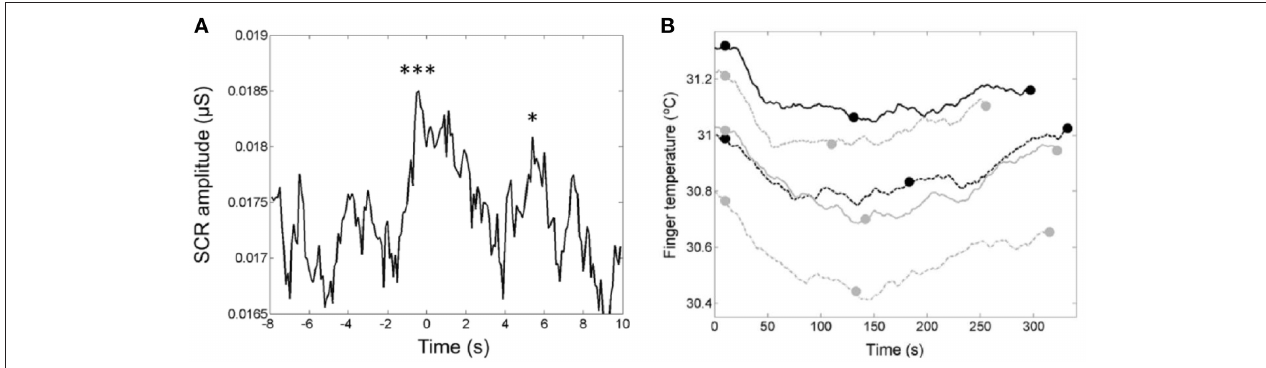
FIGURE 14 | (A) The median curve of the skin conductance response (SCR) amplitude around the entrance of the chorus. The first downbeat was set to t = 0s (Tsai et al., 2014). The two peaks are ascribed to the two closely related phases of listening experience: anticipatory “wanting” and hedonic “liking” of rewards. Reprinted with permission from Tsai et al. (2014) © 2014 Sage. (B) The u-shaped time-dependence of the finger temperatures of the listeners during presentation of the five songs. The end of the first chorus (see full dots) devides each song into two parts with a decrease of the finger temperature in the first part and an increase in the second part (Tsai et al., 2014). Reprinted with permission from Tsai et al. (2014) © 2014 Sage. The symbols *** and * indicate that the two peaks are significantly larger than the control